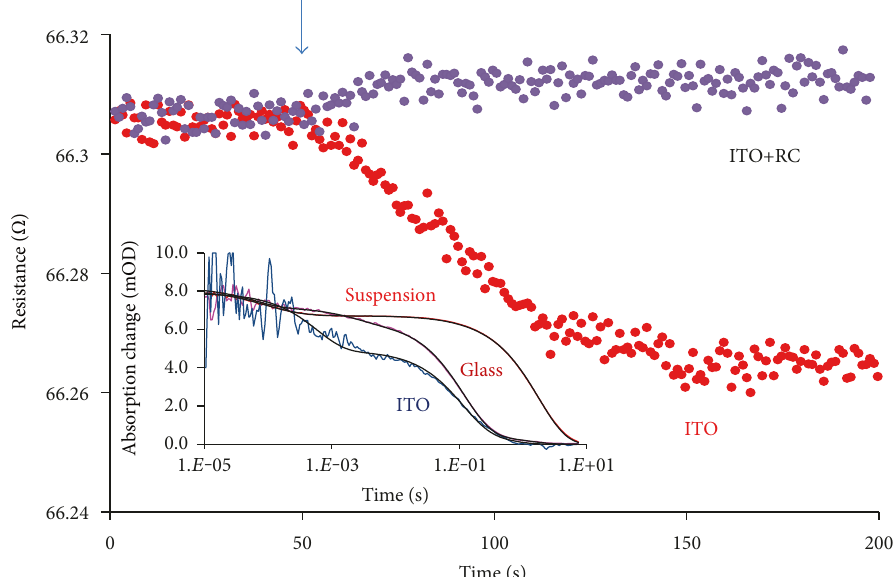
Figure 7: Light-induced conductivity changes of bare ITO and that decorated by RCs. Arrow indicates when light was switched on. Insert shows fl ash-induced absorption change at 771nm (electrochromic shift of the BPheo absorption) recorded on detergent-solubilized RC deposited on the surface of borosilicate glass and ITO, as indicated. For explanation of di ff erent ranges of the transients, compare with Figure